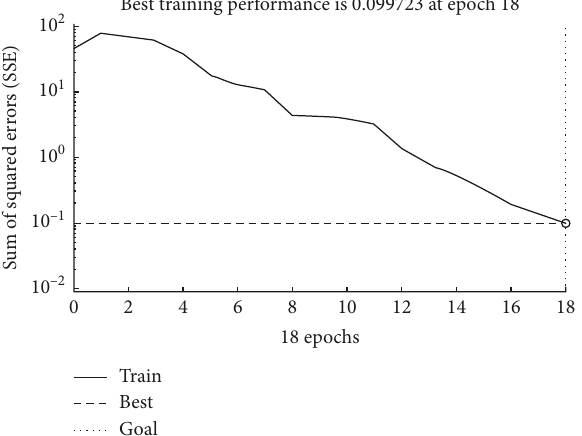
Figure 14: The iterative process of predictive model.